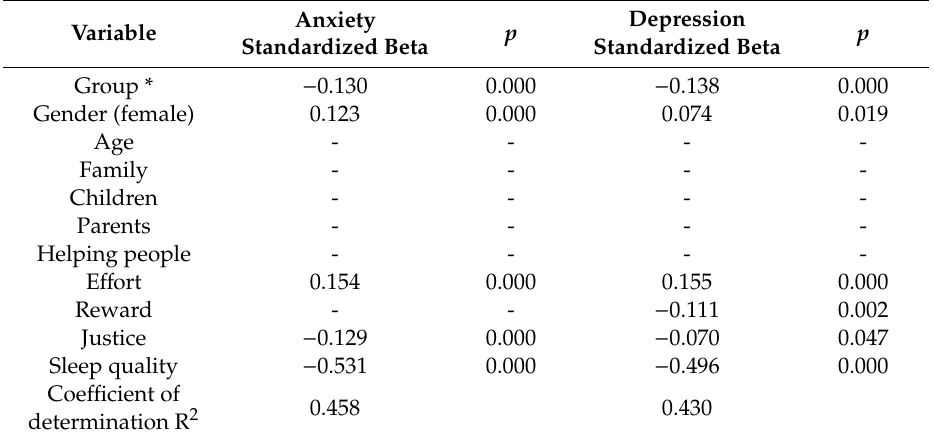
Table 6. Association of socio-demographic characteristics, occupational variables (stress, organizational justice) and sleep problems with anxiety and